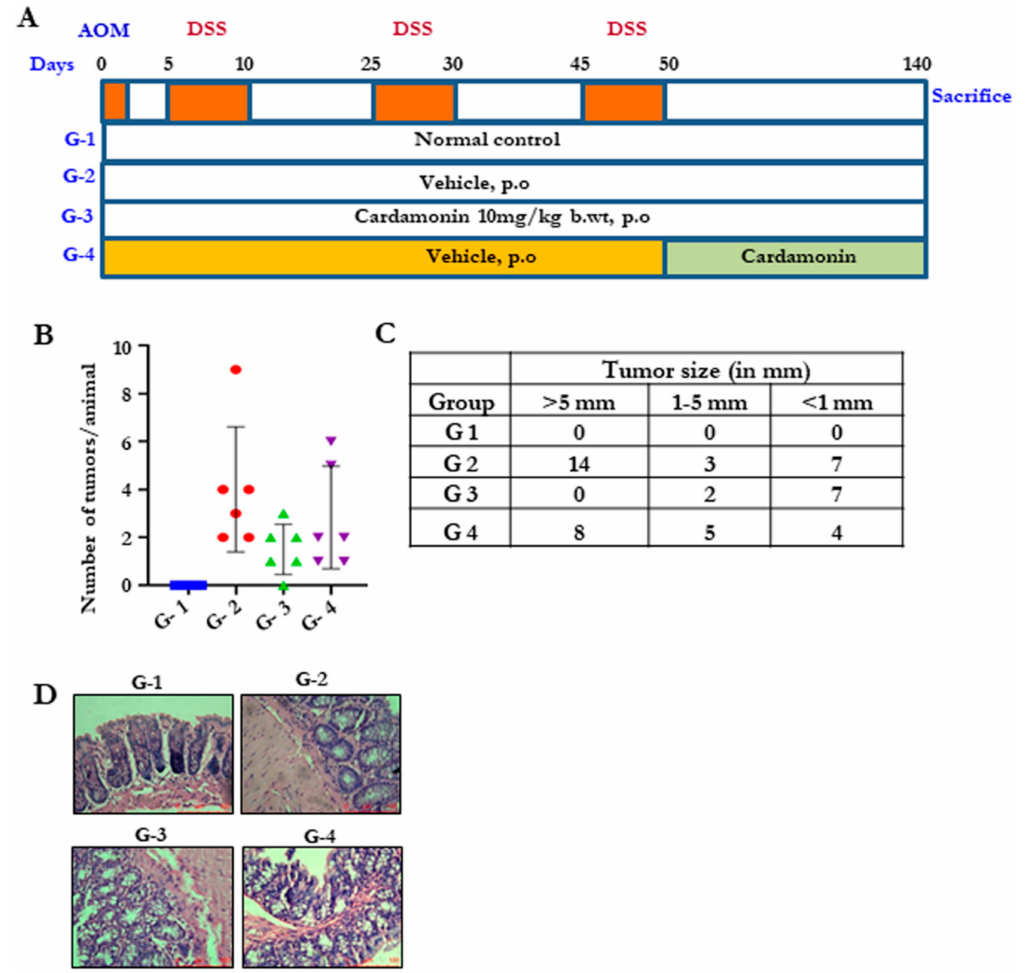
Figure 4. Cardamonin reduces tumor burden in colitis-associated colorectal cancer. ( A ) Schematic representation showing the time-bound drug treatments for establishing the AOM-induced, DSS-promoted, colitis-associated colorectal cancer model. ( B ) The effect of cardamonin on tumor number. The number of tumors per animal was counted and represented. ( C ) The effect of cardamonin on the size of the tumor (in mm). ( D ) H&E images of all four groups showing the tumor morphology, scale bar = 100 µ